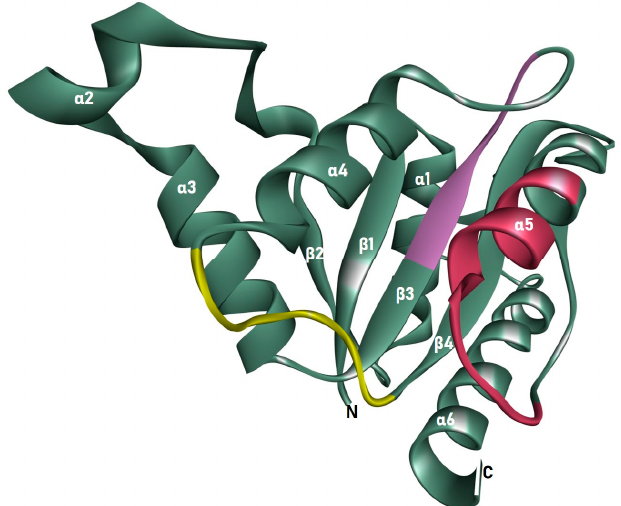
Figure 5. A cartoon illustration of ChrR from P. alcalifaciens was prepared using the BIOVIA Discovery Studio Visualizer, depicting the three motifs in yellow, purple, and red.